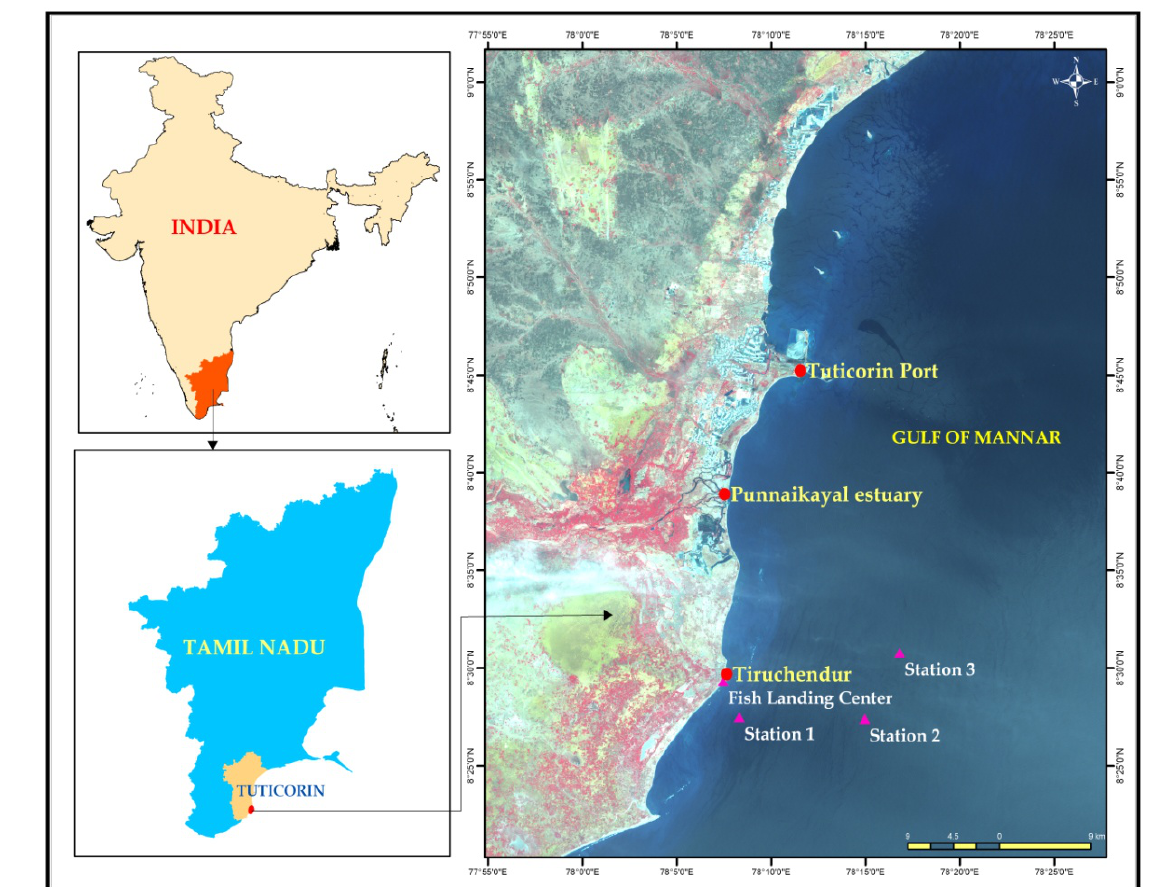
Fig. 1. Study area, Tiruchendur, Southeast coast of Tamil Nadu, Gulf of